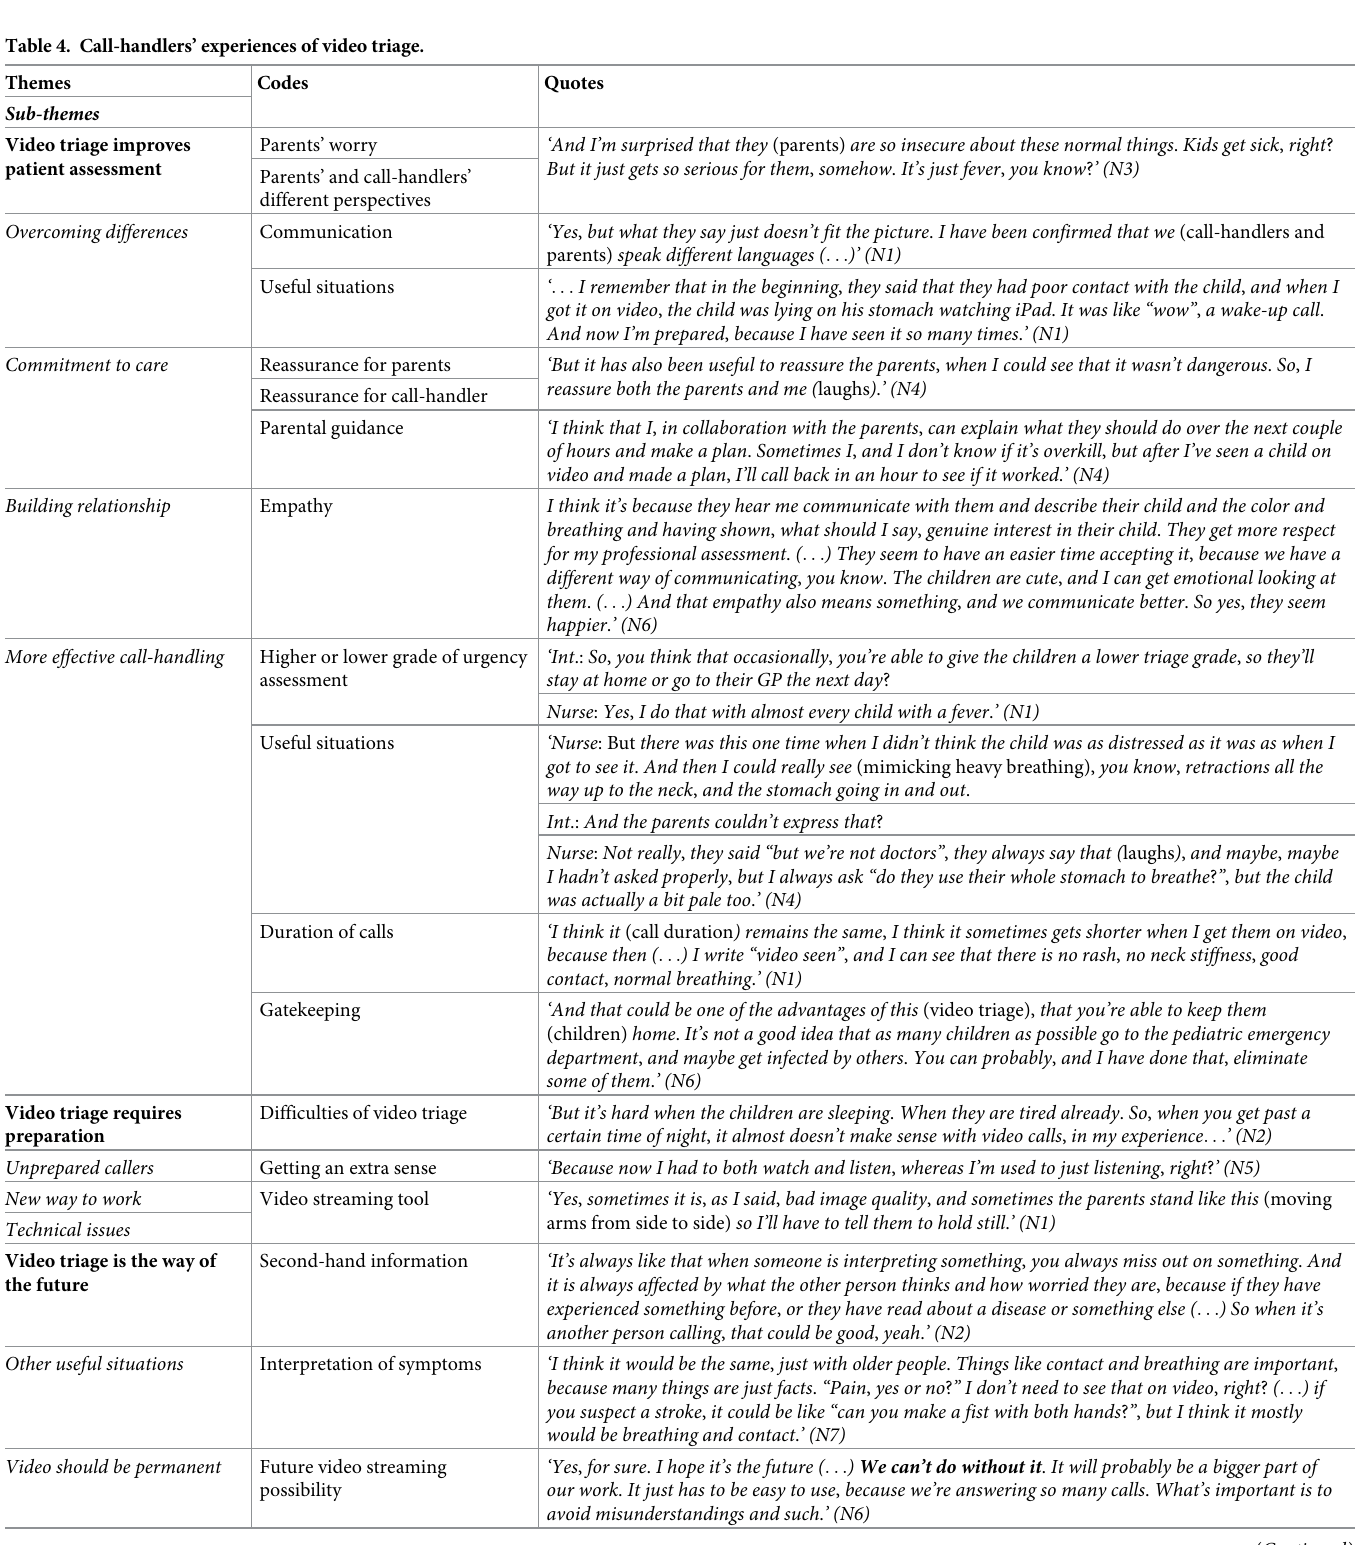
Table 4. Call-handlers’ experiences of video